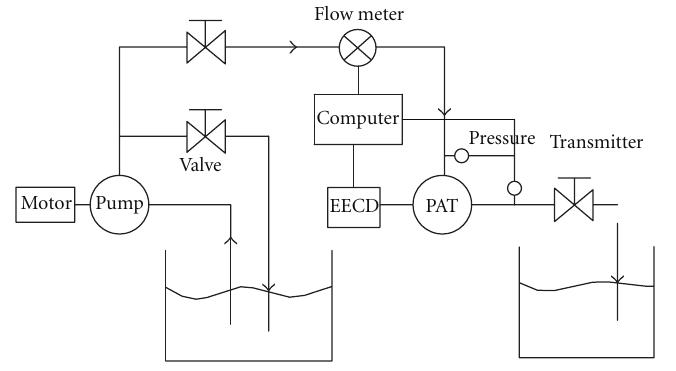
Figure 1: An open PAT test rig.